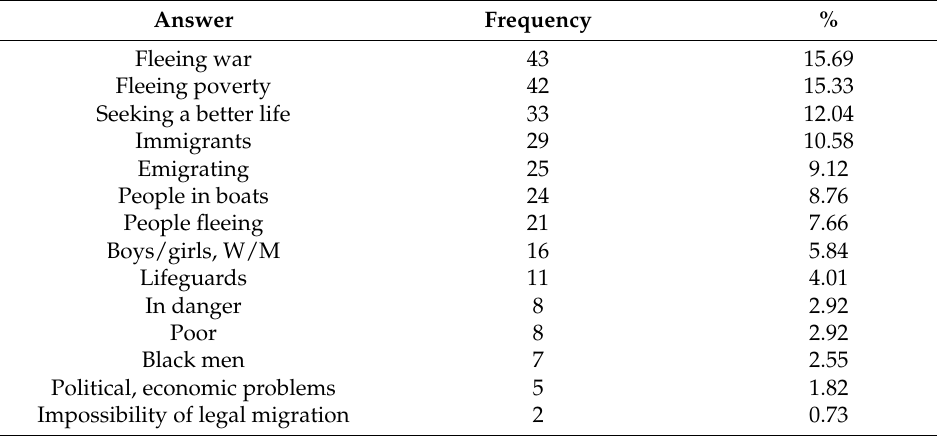
Table 2. Social representations from Figure 1